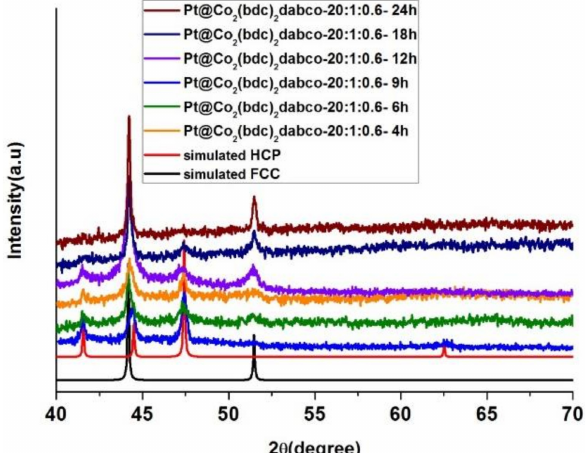
Figure 9. PXRD analysis of Pt@Co@C (20:1:0.6) at different carbonization times and a temperature of 800 ◦